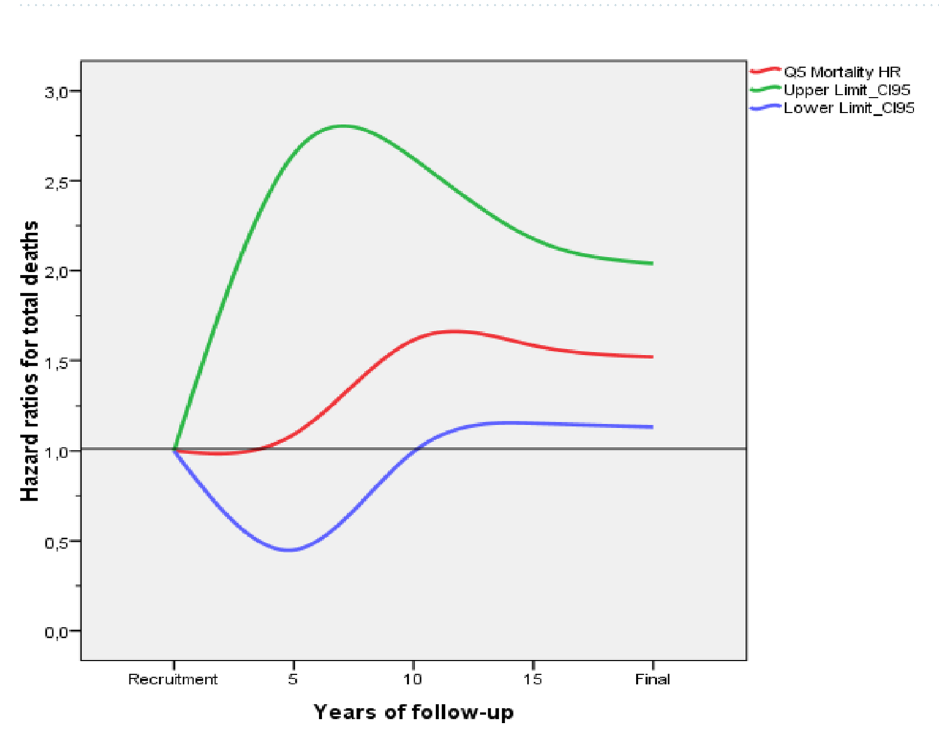
Figure 2. The sequence graph shows the evolution of hazard ratios (95% CI) of resistin Q5 for all-cause deaths at 5, 10 and 15 years of